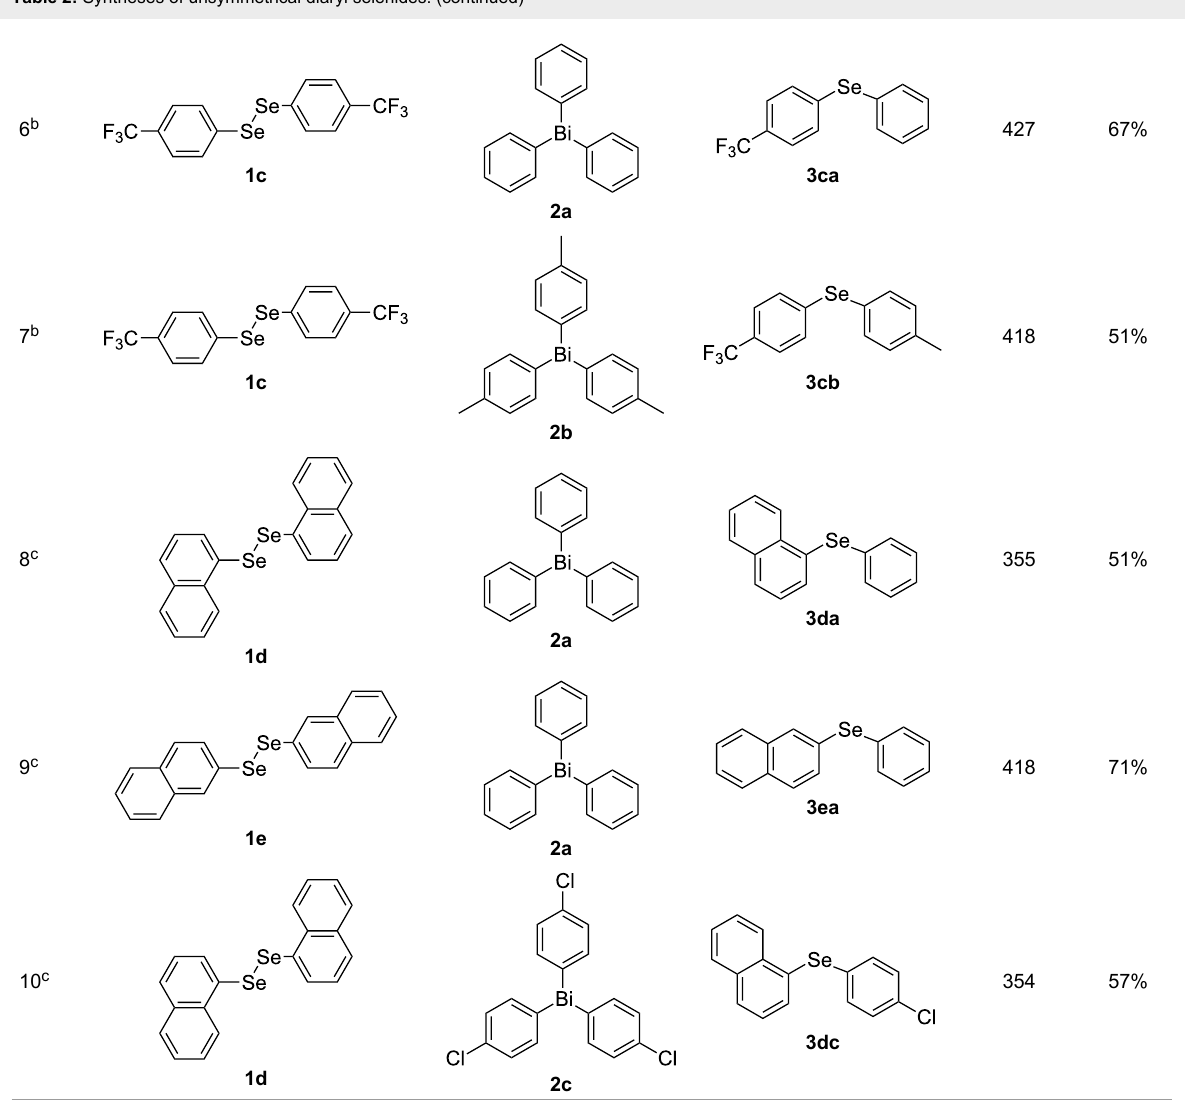
Table 2, because 77 Se NMR is a tool well suited to identify diorganyl